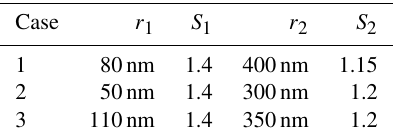
Table 1. Overview of parameters of the bimodal particle size distri- butions assumed for the forward